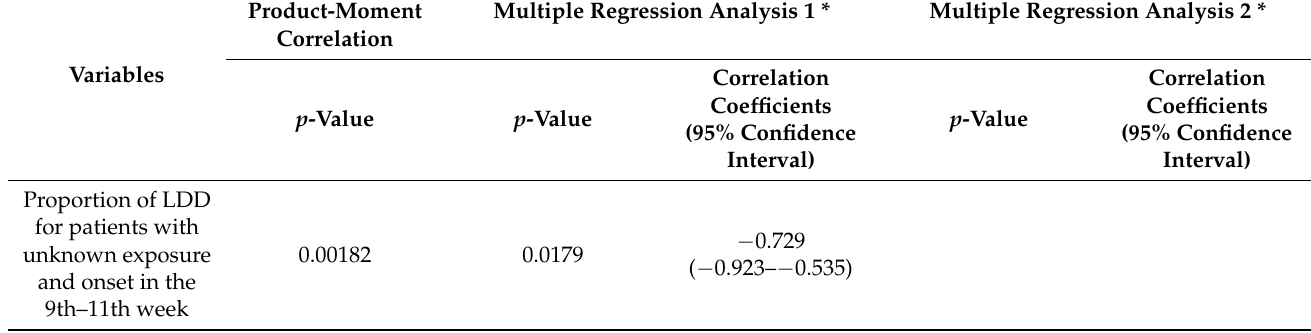
Table 2. Geographic correlation between the proportion of long diagnostic delay ( ≥ 6 days) in symptomatic COVID-19. Patients (the 9th–11th week) and the base 10 logarithm of the doubling time of the COVID-19 incidence (the 12th–13th week) among the six Japanese prefectures using a Pearson’s product-moment correlation and multivariate regression